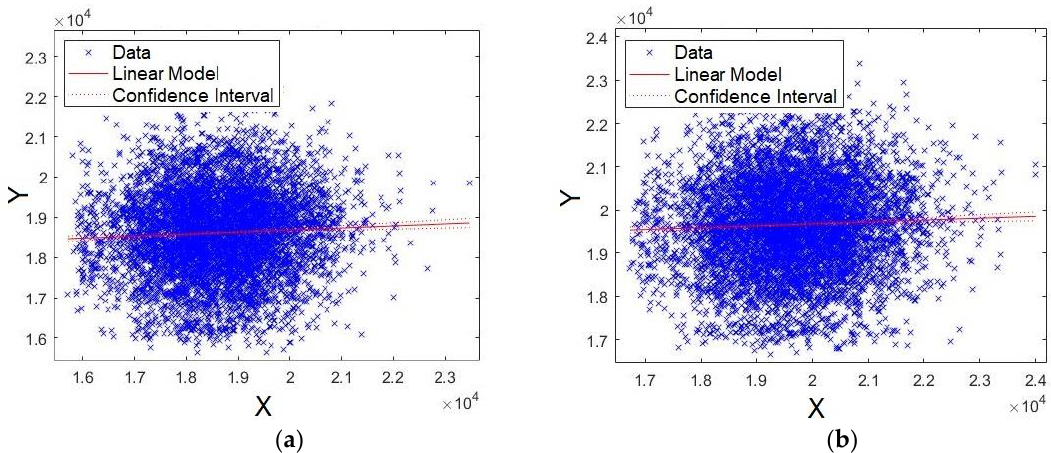
Figure 14. XY straight line for: (a) formant F17 and (b) formant F18 .